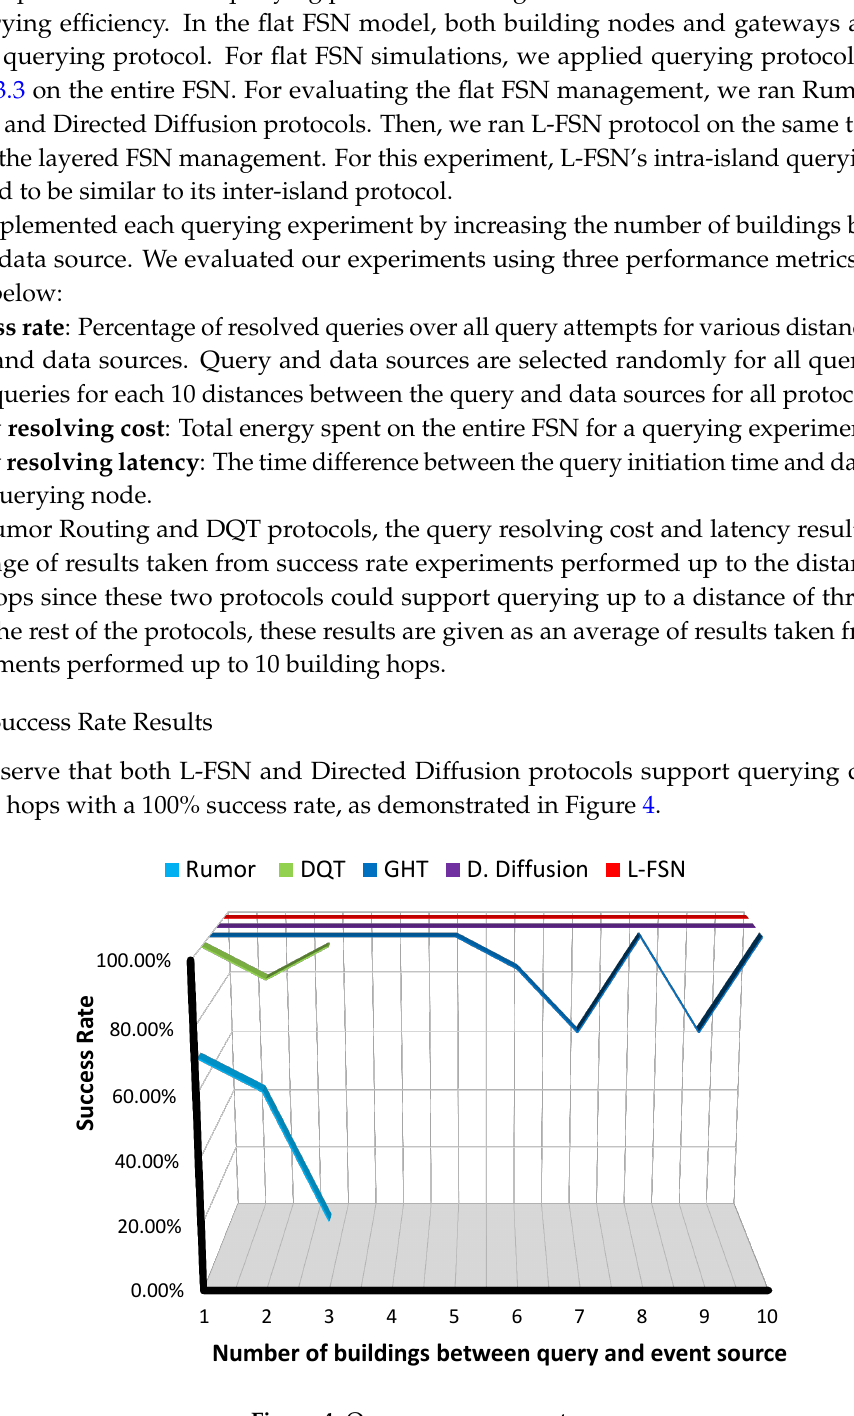
Figure 4. Query success